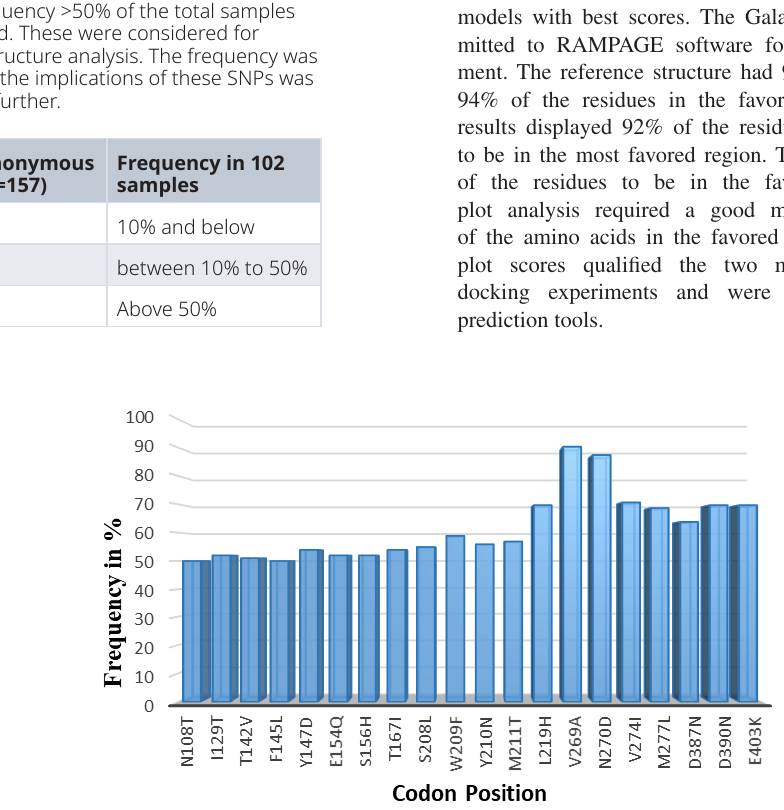
Figure 1. High frequency non-synonymous SNPs observed in sequenced data for PHISTb/RLP1 protein. Non-synonymous SNPs occurring in 50% and above of the total sample size. Codons I129T, T142V, Y147D, E154Q, S156H, T167I, S208L, M211T, L219H, D387N, D390N, and E403K were substitution of amino acids across different functional groups. These were modelled and their implications on protein structure and interactions with a drug compound